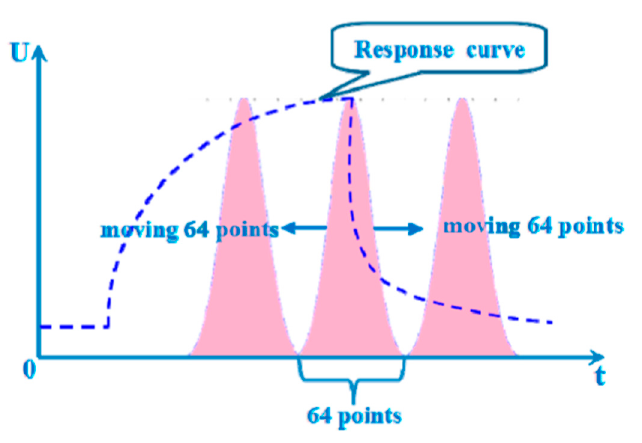
Figure 3. The schematic diagram of moving window function capturing (MWFC) [46].